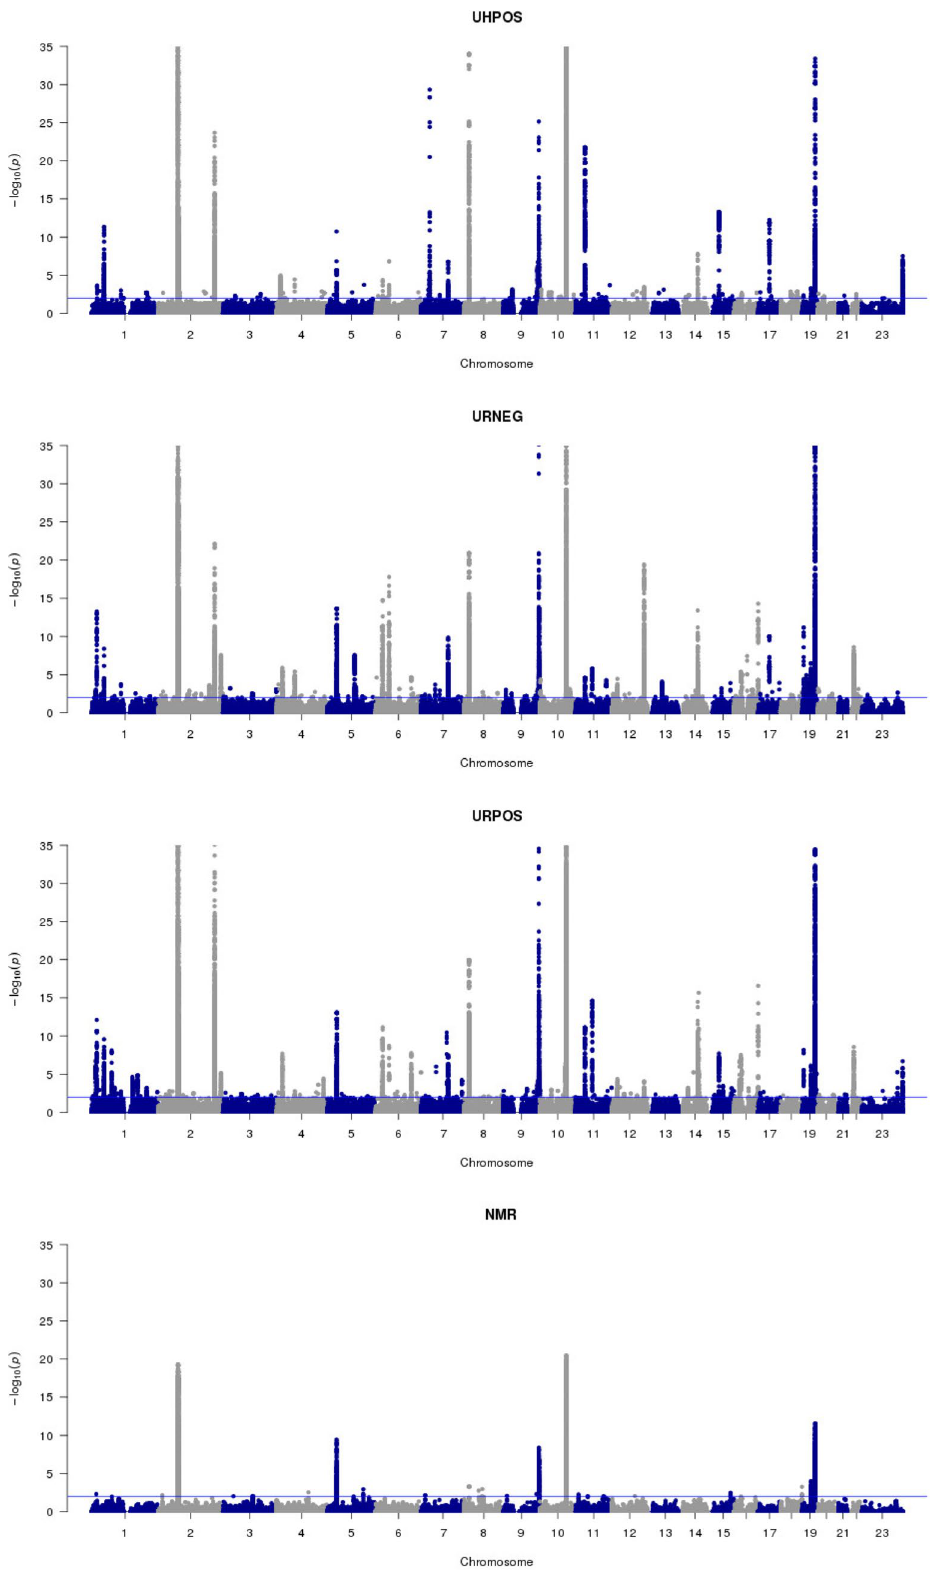
Figure 1. Manhattan plots presenting significant QTL associations with metabolic features across the metabolite phenotyping datasets. The x-axis shows each SNP that was analysed, sorted by chromosome and − position. The y-axis shows the log10 of the p-value for association with metabolic features concentration. Four sections correspond to four different metabolomic assays presented in our study: UHPOS, URNEG, URPOS and